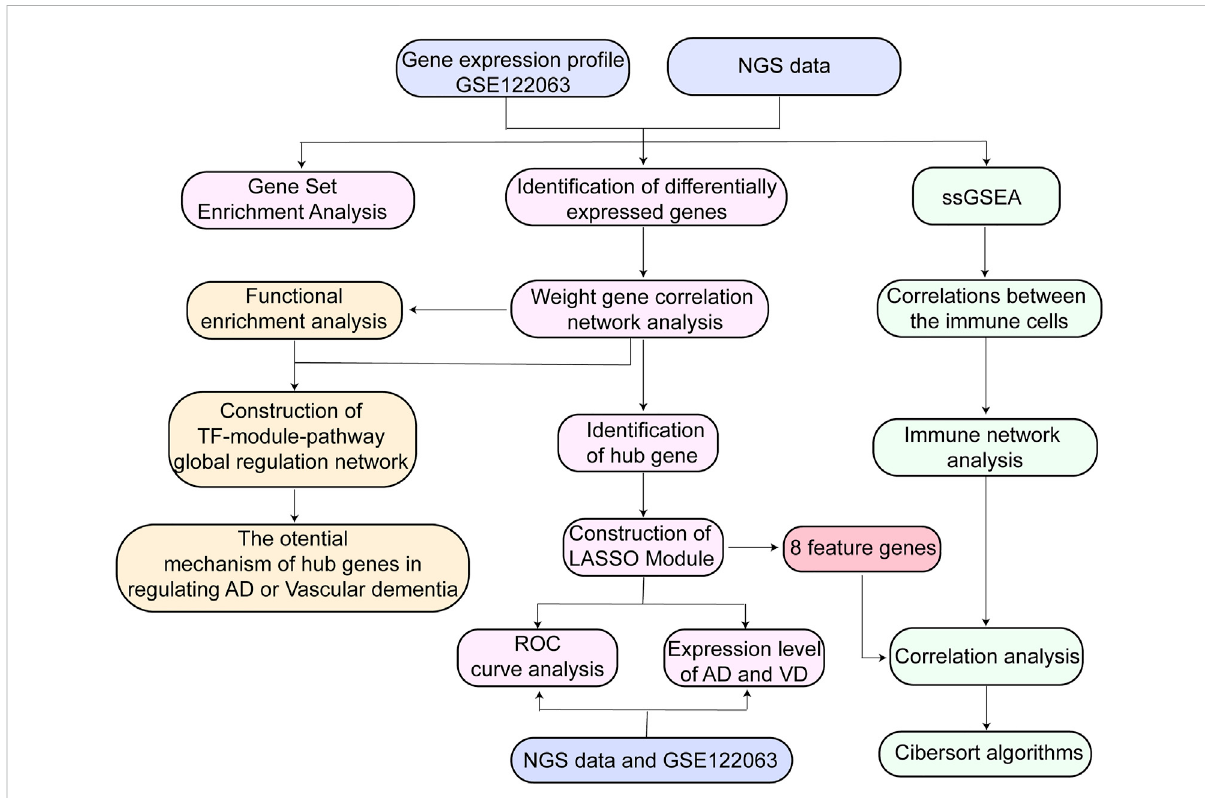
FIGURE 1 Flow chart of study design. AD, Alzheimer ’ s disease; LASSO, least absolute shrinkage and selection operator; NGS data, Next Generation Sequencing data; ROC, receiver operating characteristic curve; ssGSEA, Single Sample Gene Set Enrichment Analysis; TF, transcription factor; VD, vascular